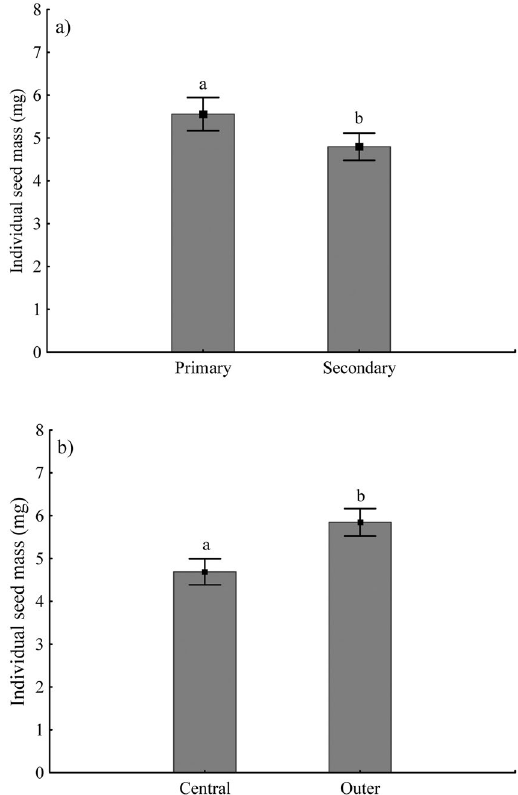
Figure 1. Differences in mean seed mass ( ± SD) between ( a ) umbel orders (primary and secondary) and ( b ) umbellet position (outer and central) in Peucedanum oreoselinum . Overall comparison between means was performed by Student’s t-test; different letters indicate significant (p < 0.05) differences between means.